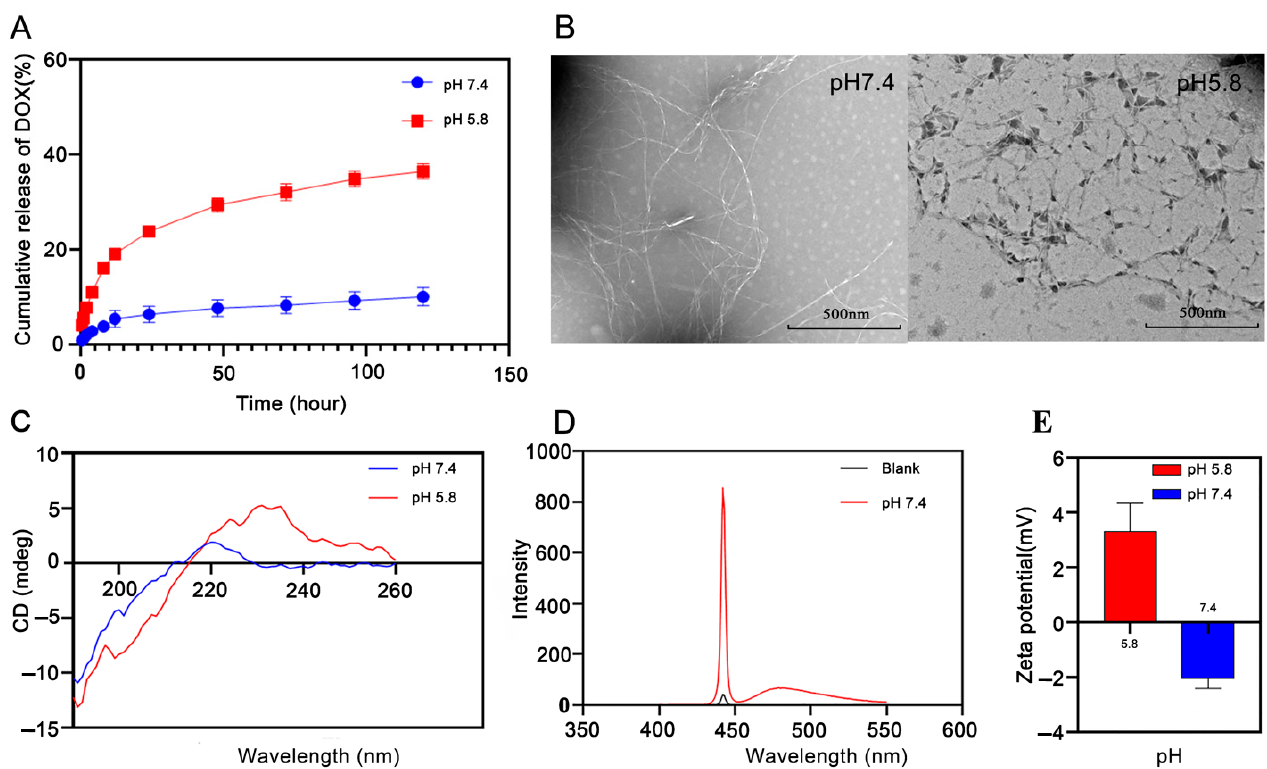
Figure 2. ( A ) Cumulative release of DOX from DOX-P1 hydrogel. ( B ) Transmission electron microscopy of 0.15 wt.% P1 hydrogel under pH 7.4 and 5.8. ( C ) CD spectrum of P1 nonapeptide under pH 7.4 and 5.8. ( D ) ThT assay of P1 nonapeptide under pH 7.4 and 5.8. ( E ) Zeta potential of P1 nonapeptide under pH 7.4 and 5.8 (n = 3). Table 2. Efficiency of drug encapsulation of nonapeptides (n = 6). Peptide P1 P2 Encapsulation efficiency (%)